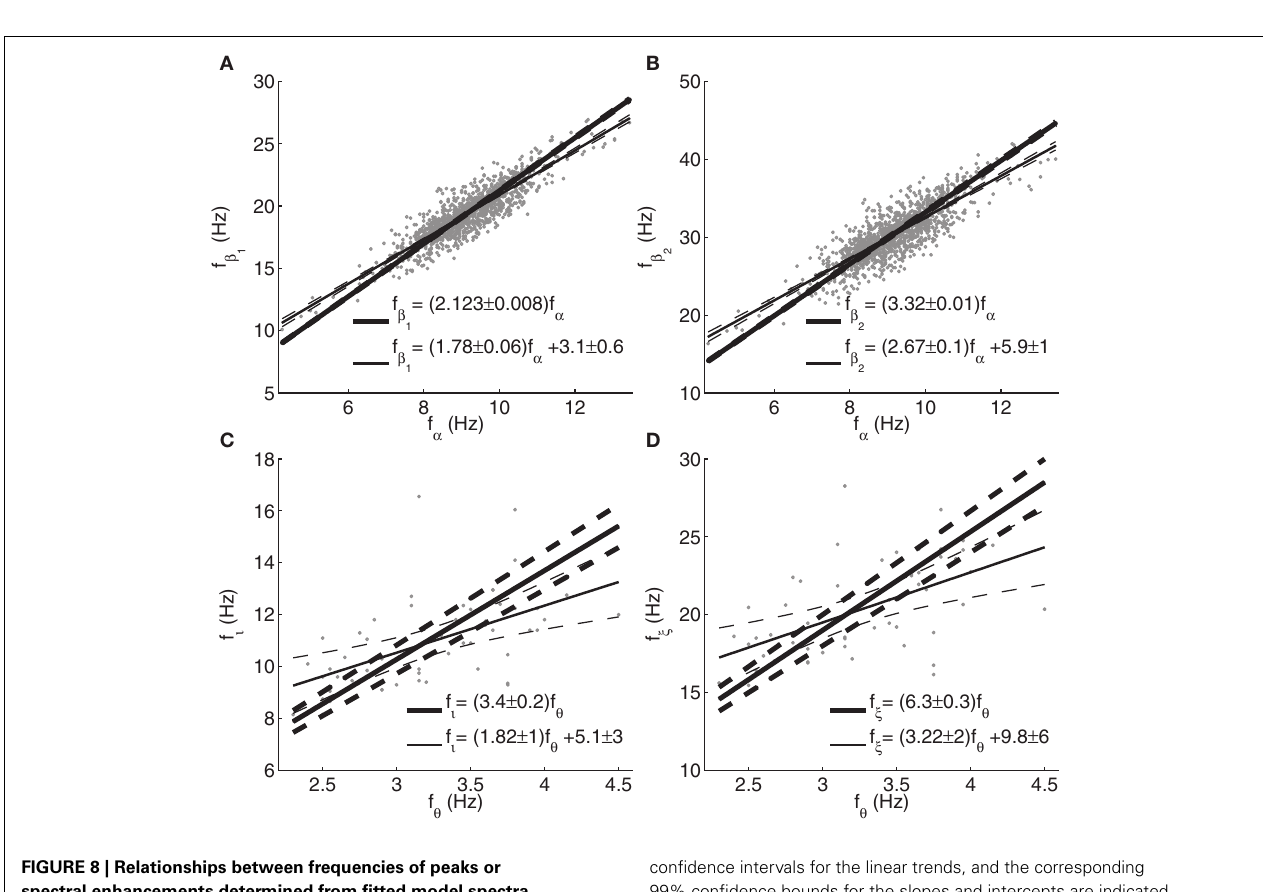
FIGURE 8 | Relationships between frequencies of peaks or spectral enhancements determined from fitted model spectra. (A) Beta 1 vs. alpha; (B) beta 2 vs. alpha; (C) iota vs. theta; (D) xi vs. theta.Thick lines, fits of frequency ratios; thin lines, linear fits with intercept. Dashed lines represent 99% non-simultaneous